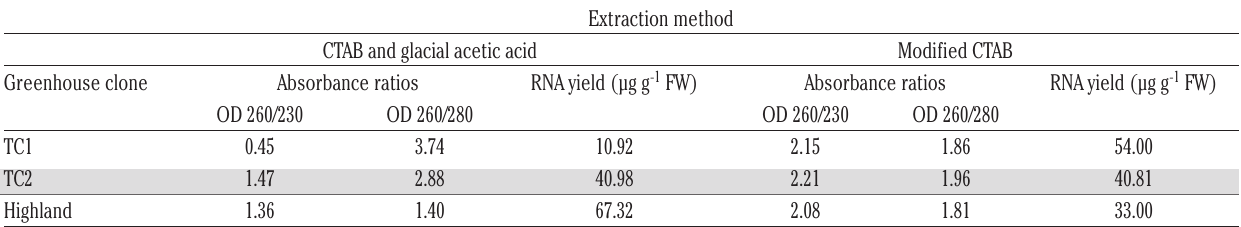
Figure 3. Polymerase chain reaction pro- files of first strand cDNA amplified from greenhouse-grown A. annua L. RNA iso- lated through modified cetyltrimethyl- ammonium bromide (CTAB) protocol (1- 3) and CTAB plus glacial acetic acid method (4-6) using universal primers ITS1F and ITS4R. 1 and 4, TC1; 2 and 5, TC2; 3 and 6, Highland; M, 100bp DNA Marker (Fermentas).